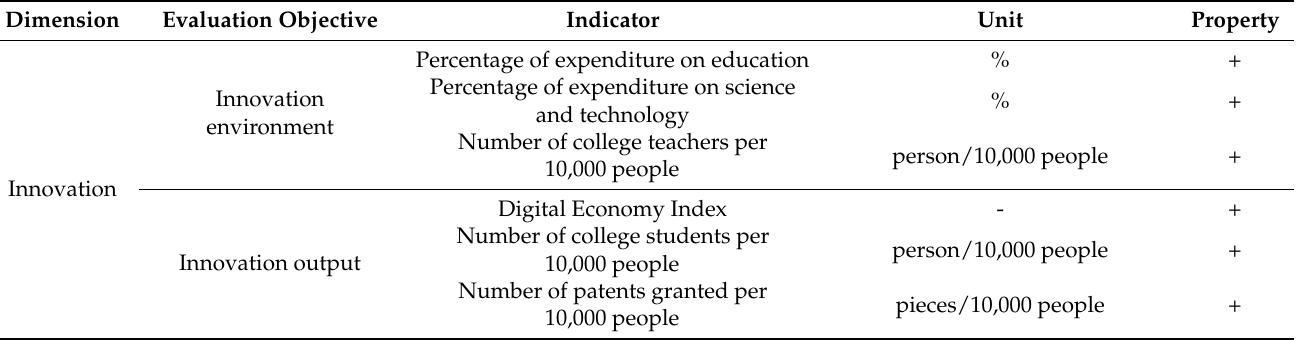
Table 2. Comprehensive measurement index system of